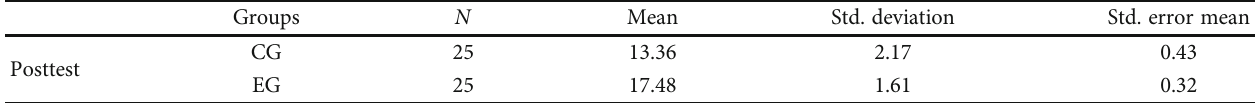
Table 6: Group statistics (delayed posttest of both groups).